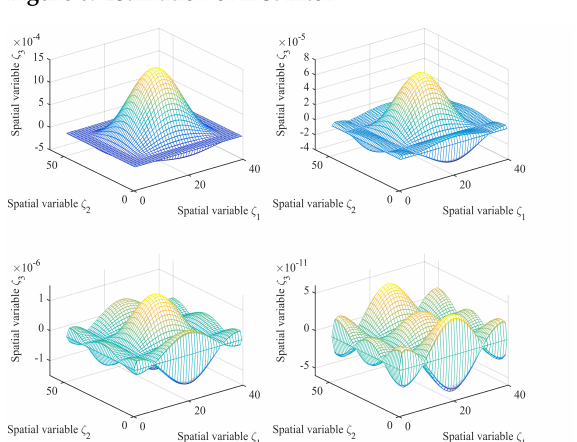
Figure 6. Estimation of first filter.